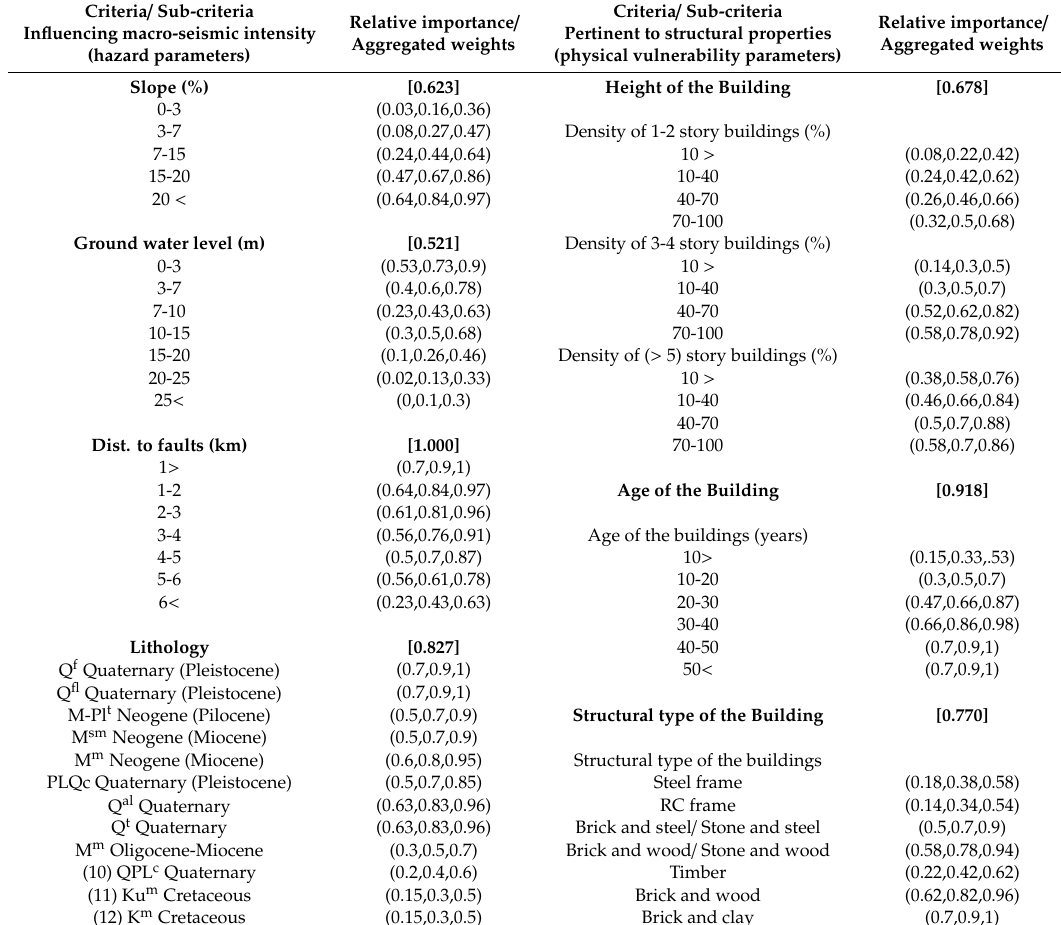
Table 2. The influencing criteria / sub-criteria and used weights based on the experts’ opinions. Criteria / Sub-criteria Influencing macro-seismic